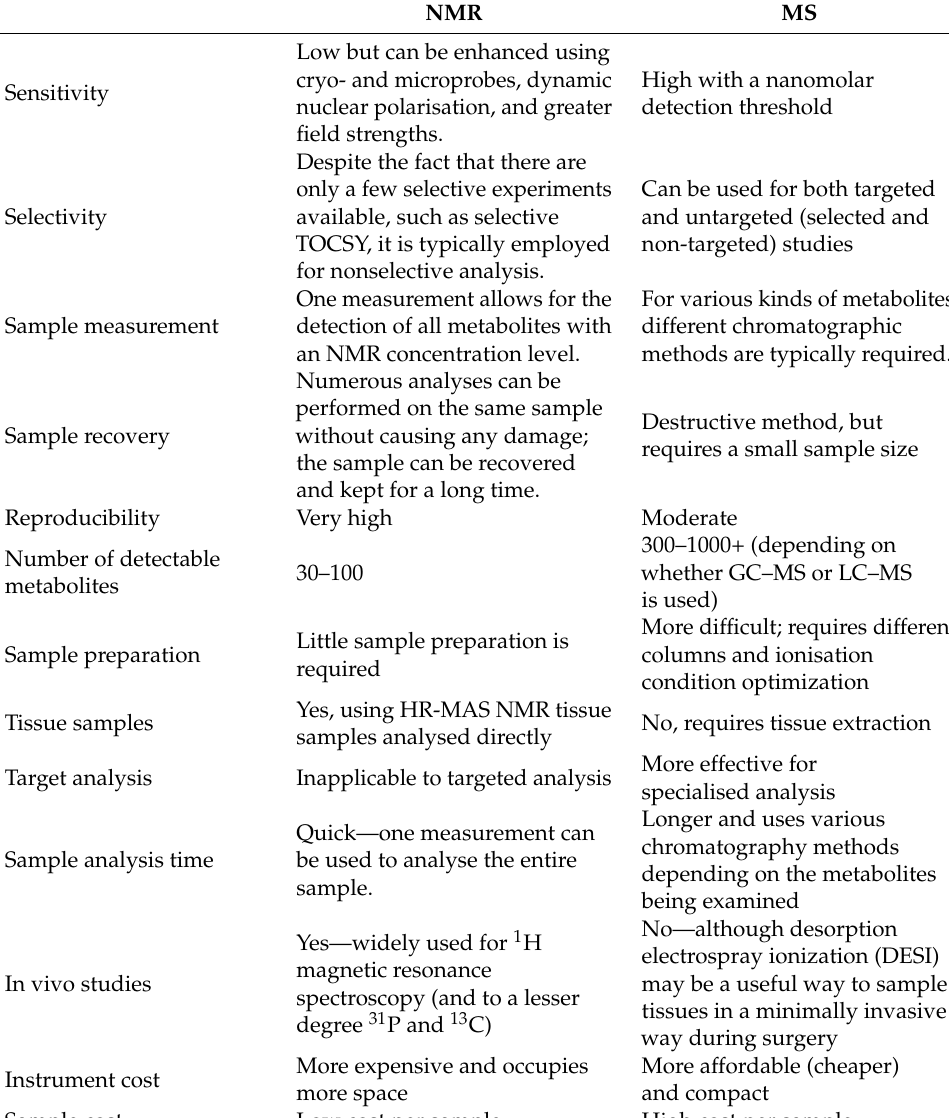
Table 3. Advantages and limitations of NMR- and MS-based metabolomics